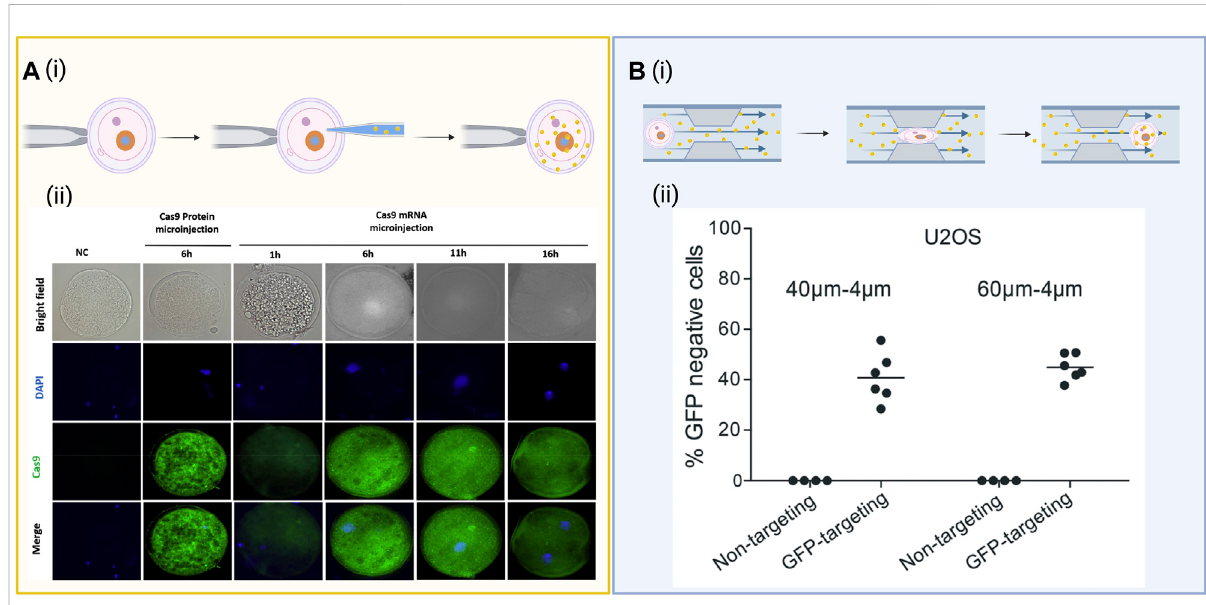
FIGURE 2 Diagramsofcommonbiophysicaldeliverymethods. (A) (i)Schematicofamicroneedledirectlyinjectinggeneeditingcargointothenucleusofa cell. (ii) Evaluation of Cas9 expression over 16 h when microinjected as messenger RNA (mRNA), the protein itself (positive control), and a nuclease- free injection of water (negative control) under both bright fi eld and immuno fl uorescent staining. Images reproduced from ref (Li et al., 2021) with permission from Theriogenology. License CC BY-NC-ND 4.0 https://creativecommons.org/licenses/by-nc-nd/4.0/. (B) (i) Cell squeezing involves passing the cells through a micrometer-sized constriction at high speeds to form transient pores along the cellular membranes. The cargo can diffuse into the cell through the pores before the membrane reassembles. (ii) Flow cytometry data for expression of green fl uorescent protein (GFP) after delivery of aCas9 ribonucleoprotein (RNP) complexedto either a GFP-targeting or nontargeting guide RNA (gRNA) after